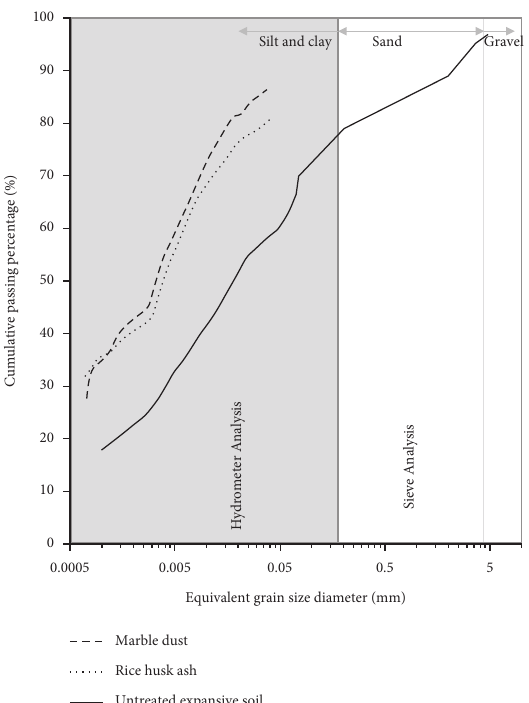
Figure 3: Particle size distribution curve of marble dust, rice husk ash, and expansive soil.